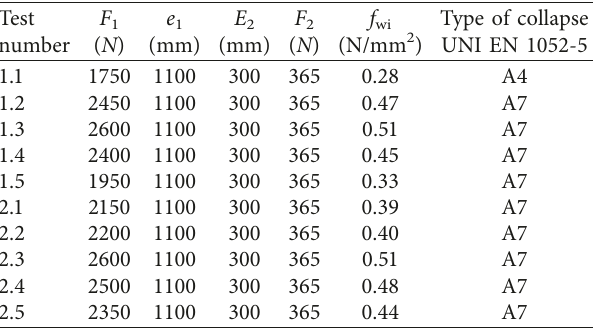
Table 2: Specimen 2: Gasbeton 63 × 25 × 24cm and foam for masonry.